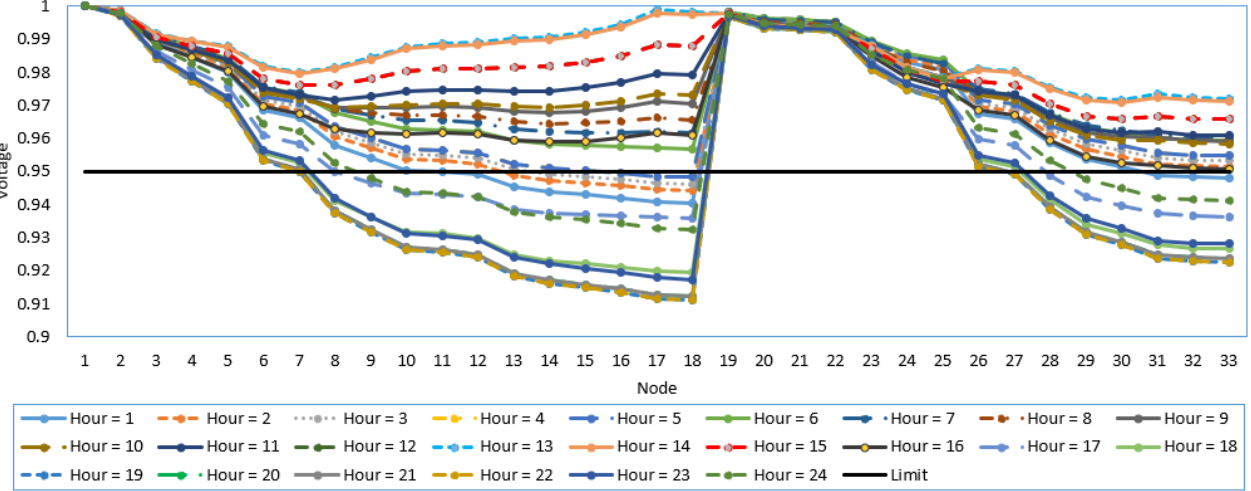
Figure 11. Hourly voltage profile for the second for the IEEE 33-distribution system.